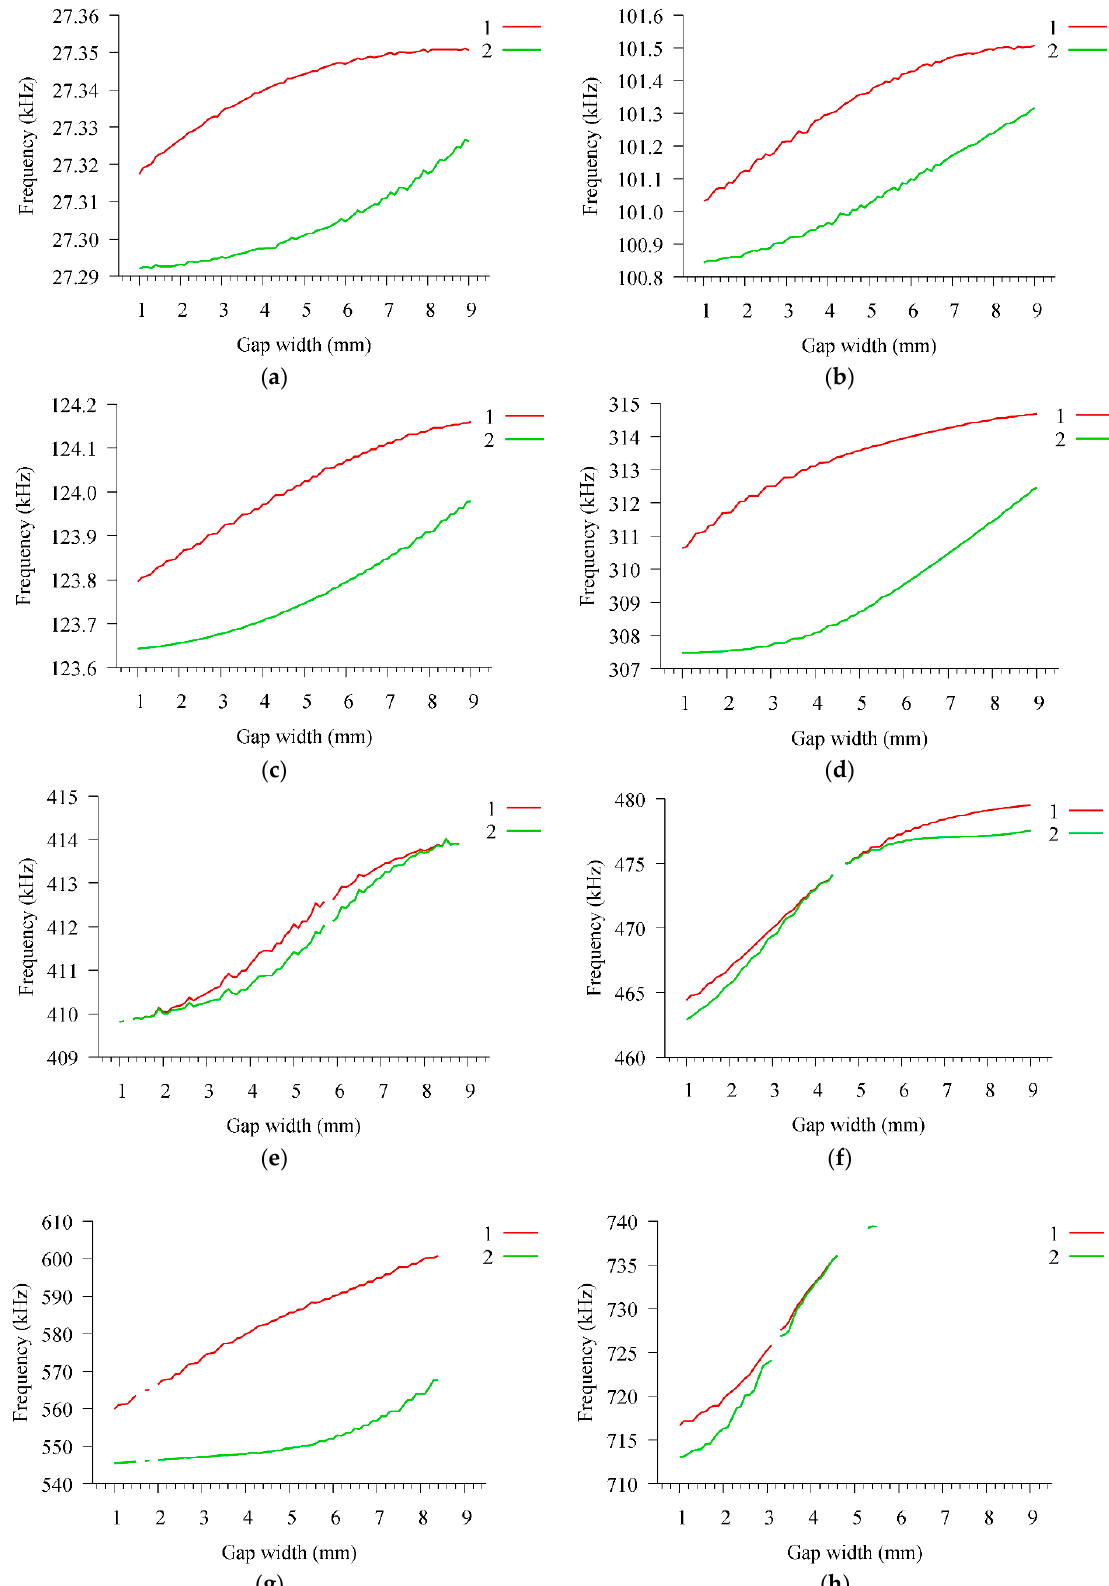
Figure 8. Dependences of the frequencies of (1) parallel and (2) series resonances on the width of the gap between the electrodes g for the modes ( a ) F0, ( b ) F1, ( c ) R0, ( d ) R1, ( e ) F3, ( f ) TE0, ( g ) F5, and ( h ) TE2. Gaps (absence of colored lines) in some plots at certain values of e 1 and g mean that at a given position of the electrodes the corresponding mode is absent or its quality factor is Q < 1. The flexural mode F0 mode has the maximum quality factor, its Q-factor can reach 12,000 (at a given value of the viscosity factor η ). The quality factor of the rest of the modes ranges from several hundred to several thousand. There is a change in the value of the electromechanical coupling coefficient deter- mined by formula (14) over a wide range. The maximum value of k 2 is equal to 12.4% and is observed for the F5 mode ( f par = 544–590 kHz) at a gap value g = 5.8 mm. 4. Discussion A new type of disk piezoceramic resonator was presented in the work—a resonator with a radial exciting field. The difference between the presented type of resonator and a disk resonator with electrodes at the ends of the disk (resonator with a longitudinal field) is that both electrodes are located at the same end of the disk. This leaves the second end of the disk free for contact with the medium under study, which makes such a resonator suitable for creating a sensor for both mechanical and electrical properties of the medium. In this case, the selected shape of the electrodes retains the axial symmetry of the disk, which greatly simplifies its mathematical modeling by a two-dimensional finite element method. This is the advantage of the presented type of resonators relative to resonators with a transverse exciting field with flat electrodes [5–8], which cannot be correctly mod- eled by a two-dimensional finite element method in a wide frequency range. The combi- nation of these properties makes it possible to apply the methods of broadband ultrasonic spectroscopy both to the resonator itself to refine its characteristics and to the resonator in acoustic contact with the medium under study, which makes it possible to determine the acoustic and electrical characteristics of the medium using just one broadband measure- ment. The use of such a resonator to determine the properties (speed of sound, viscosity, dielectric permittivity, and electrical conductivity) of a viscoelastic film applied to the free end of the resonator, as well as the properties of a liquid, will be the subject of further research. The peculiarities of the investigated resonator should include the presence of flexural modes, which are absent in disk resonators with a longitudinal electric field [21]. Difficulties in working with resonators of this type lie in the need to ensure a constant temperature during the entire broadband measurement, which can be quite long. 5. Conclusions This paper presents a new type of piezoceramic acoustic disk resonator with a radial exciting electric field. The advantage of this type of resonator is the localization of the